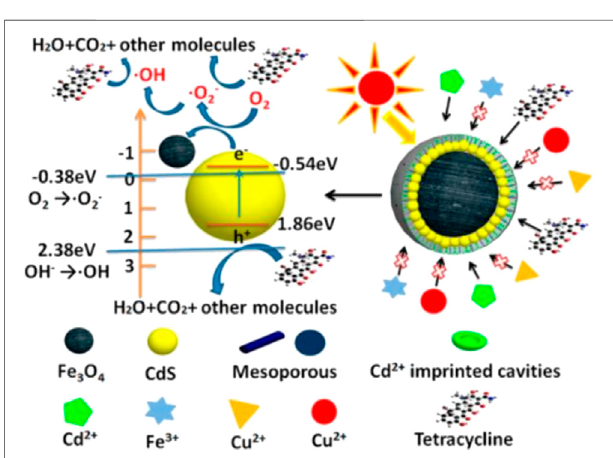
FIGURE 7 | Proposed photocatalytic and selective mechanism of the MHP-Cd. Copyright 2019, American Chemical Society (Lu et al., 2019).